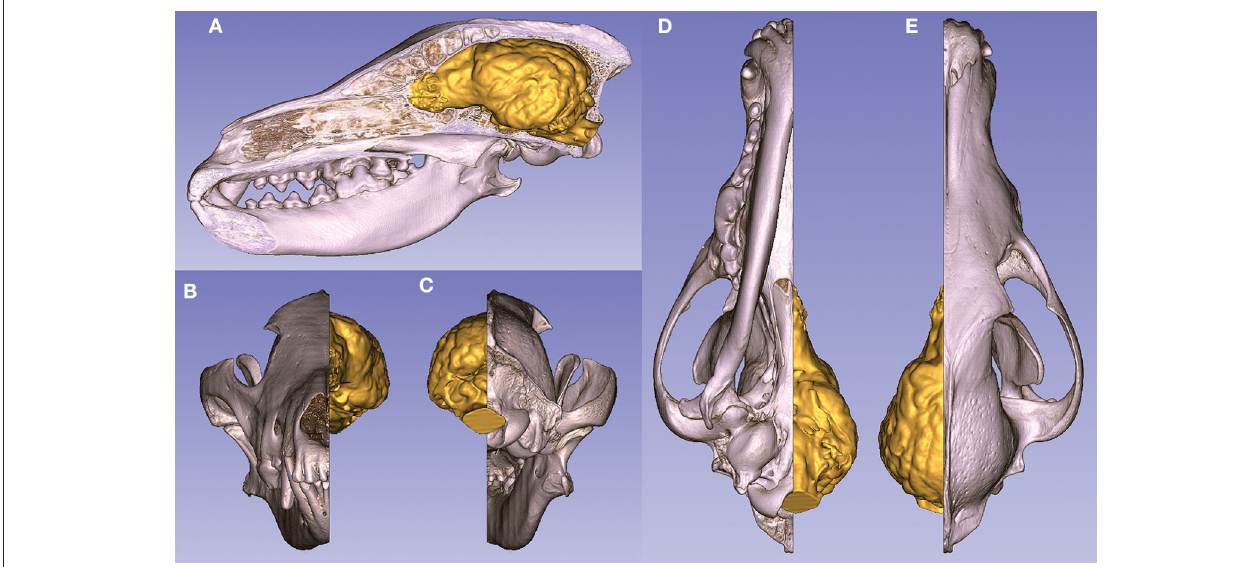
FIGURE 11 | Volume-rendered skull model (with a midsagittal section) and the endocast of a gray wolf. (A) Left lateral view. (B) Rostral view. (C) Caudal view. (D) Ventral view. (E) Dorsal view.